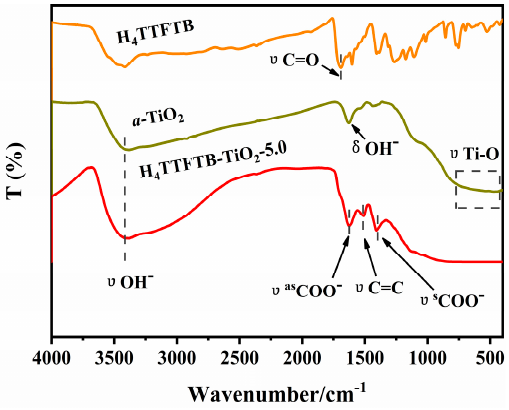
Figure 4. The FT-IR spectra of H 4 TTFTB-TiO 2 − 5.0, H 4 TTFTB, a -TiO 2 .